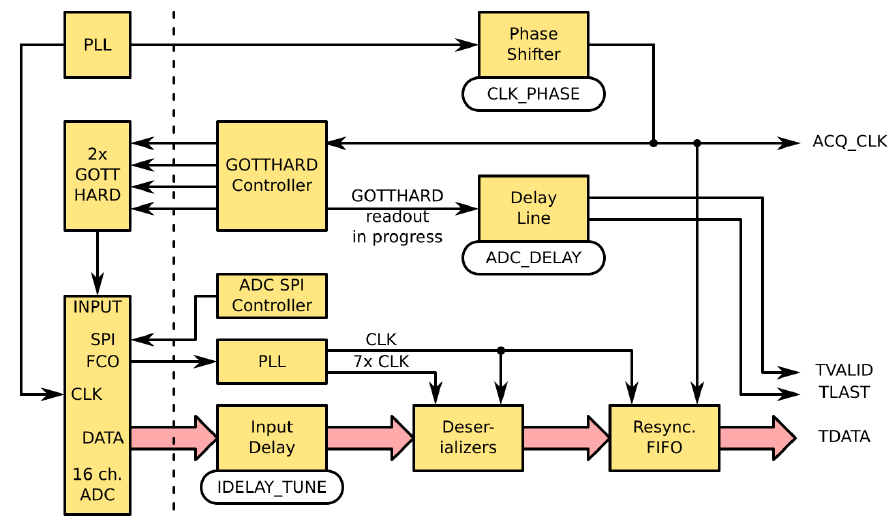
Figure 7. A block diagram of the ADC readout